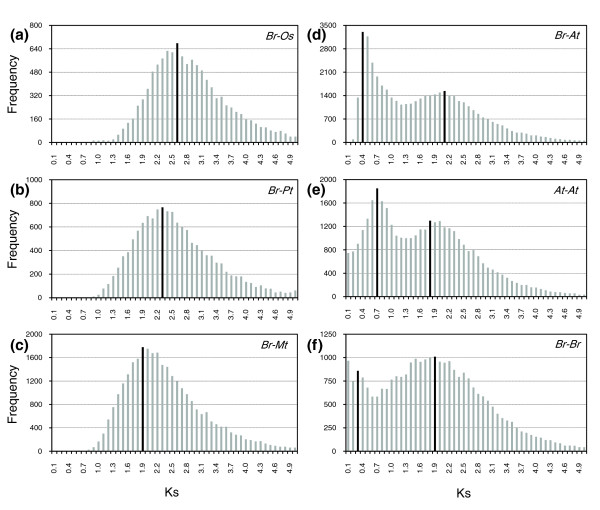
Traces of polyploidy events in plant genomes. (a-f) The distribution of Ks values obtained from comparisons of sets of putative orthologous genome sequences between Br and the selected model plant species Os (a), Pt (b), Mt (c), and At (d), and from paralogous sequences in At (e) and Br (f) genomes. The vertical axes indicate the frequency of paired sequences, while the horizontal axes denote Ks values with an interval of 0.1. The black bars depict the positions of the modes of Ks distributions obtained from orthologous or paralogous gene pairs. At, A. thaliana; Br, B. rapa; Mt, Medicago truncatula; Os, O. sativa; Pt, Populus trichocarpa.